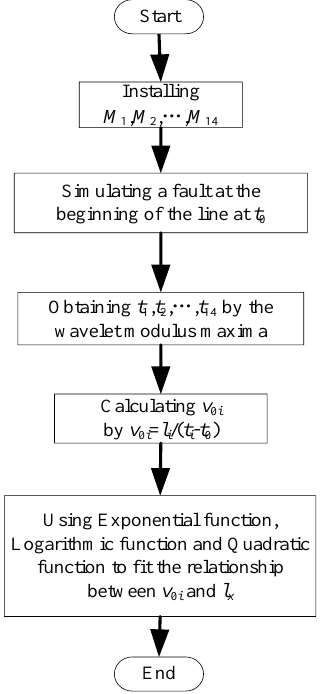
Figure 5. A flowchart of fitting the relationship between v 0 and l x .